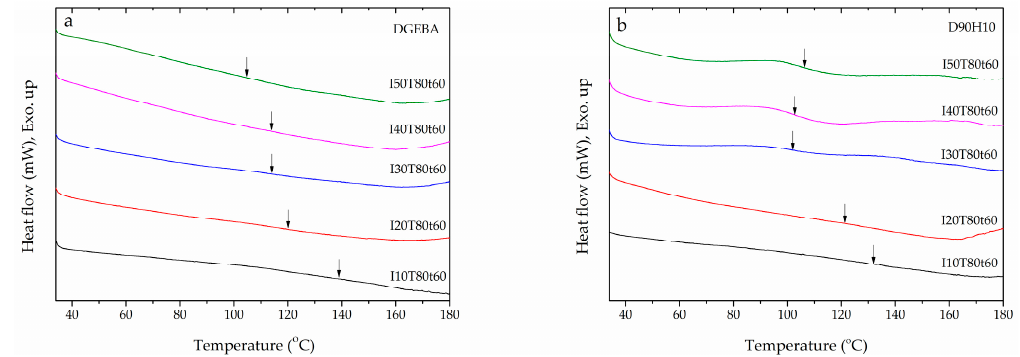
Figure 9. DSC thermograms showing glass transition temperature of ( a ) DGEBA and ( b ) D90H10 thermosets cured at various UV intensity.